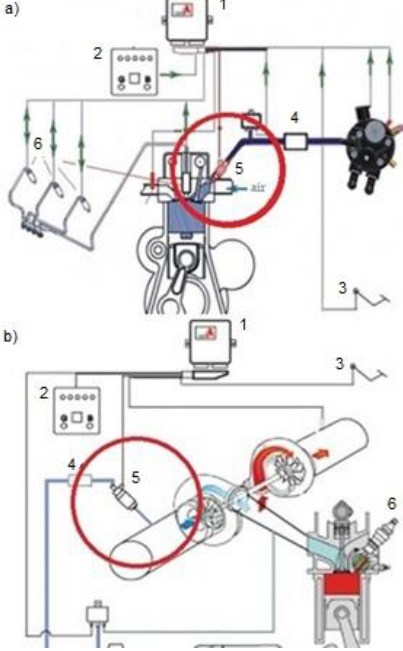
Fig. 2. Comparison of dual fuel systems: a) sequential gas injection pre- intake valve (controlled by diesel injection signals), b) pre-turbocharger gas injection: 1 – gas ECU, 2 – operation mode switch, 3 – acceleration pedal, 4 – gas filter, 5 – gas injector, 6 – diesel injector (based on [10,